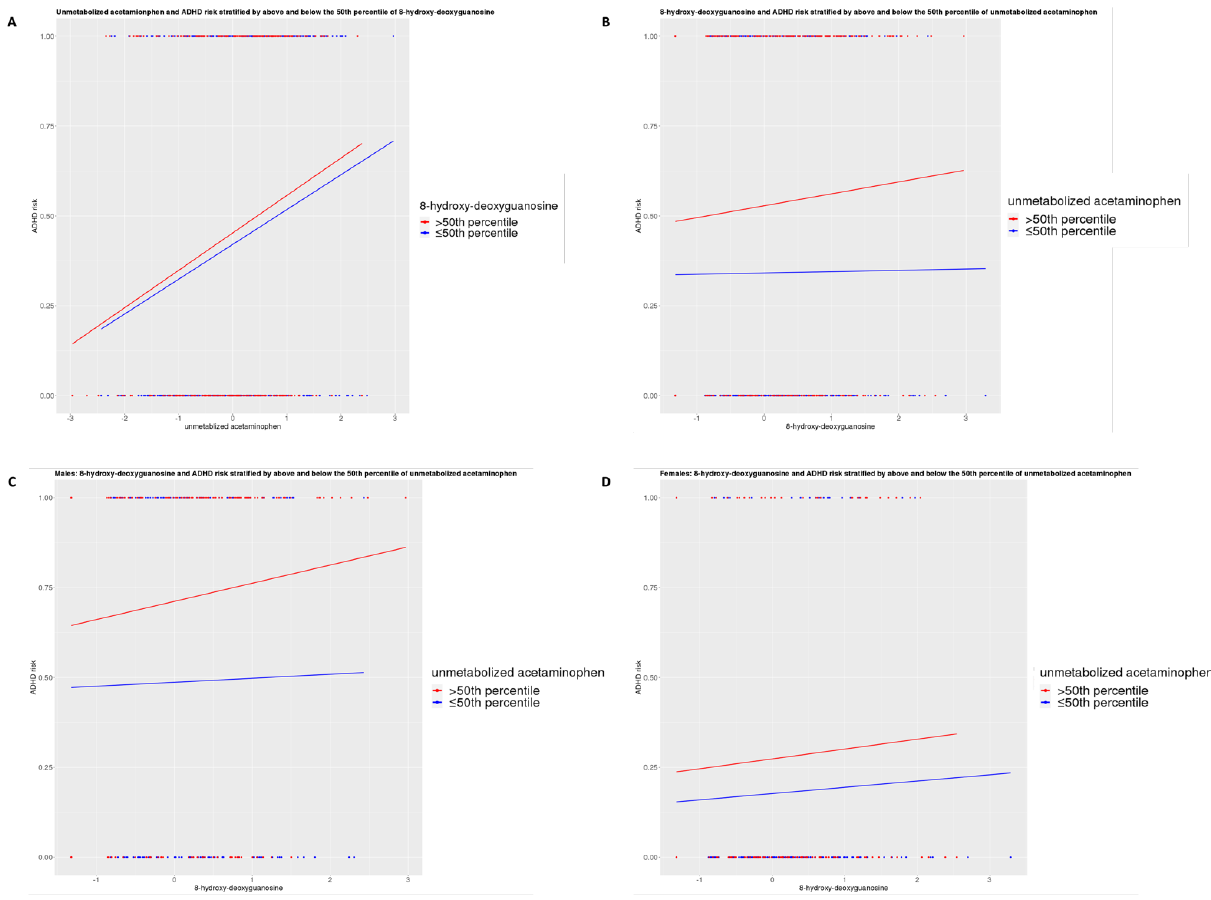
Figure 4. Inter-relationships of cord plasma unmetabolized acetaminophen a , 8-hydroxy-deoxyguanosine a , and childhood ADHD b . ( A ): Cord unmetabolized acetaminophen and ADHD risk stratified by cord 8-hydroxy-deoxyguanosine above and below 50th percentile. ( B ): Cord 8-hydroxy-deoxyguanosine and ADHD risk stratified by cord unmetabolized acetaminophen above and below 50th percentile. ( C ): Males: cord 8-hydroxy-deoxyguanosine and ADHD risk stratified by cord unmetabolized acetaminophen above and below 50th percentile. ( D ): Females: cord 8-hydroxy-deoxyguanosine and ADHD risk stratified by cord unmetabolized acetaminophen above and below 50th percentile. a Inverse normal transformed intensities. b Reference group = neurotypical development.